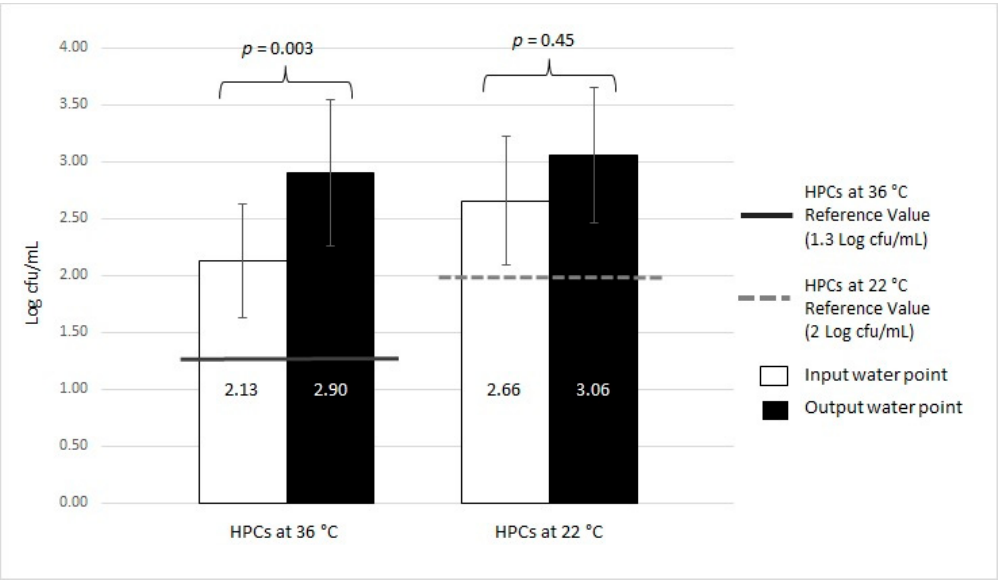
Figure 4. Microbiological contamination of MWDs (input vs. output) based on HPCs analysis at 36 °C and 22 °C.